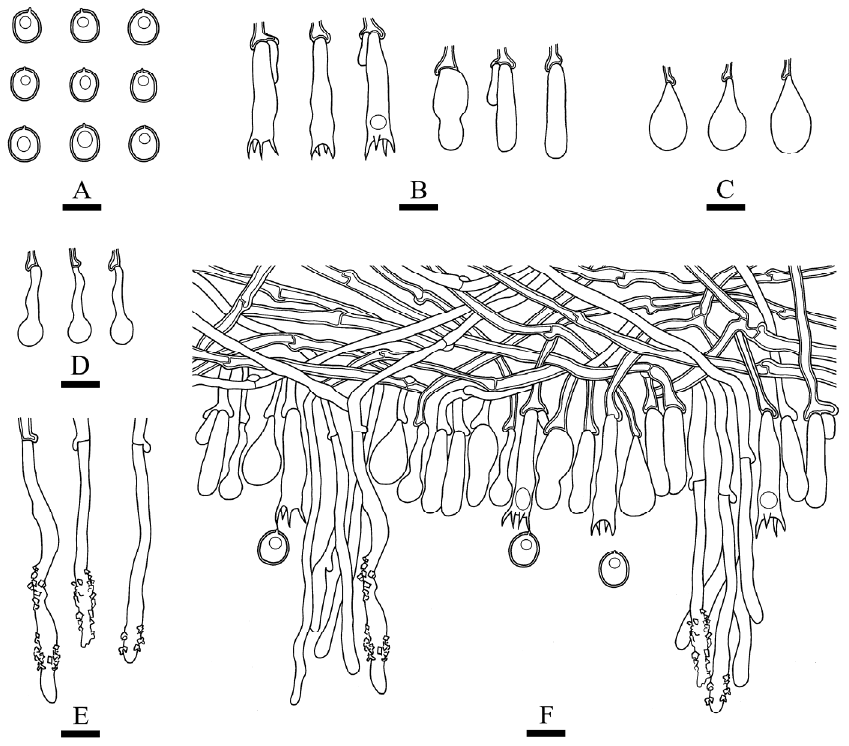
Figure 8. Microscopic structures of Xylodon macrosporus (holotype) ( A ): basidiospores ( B ), basidia and basidioles ( C ), cystidia ( D ), capitate cystidia ( E ), and cylindrical cystidia ( F ). A section of hymenium. Bars: a–f = 10 µm.